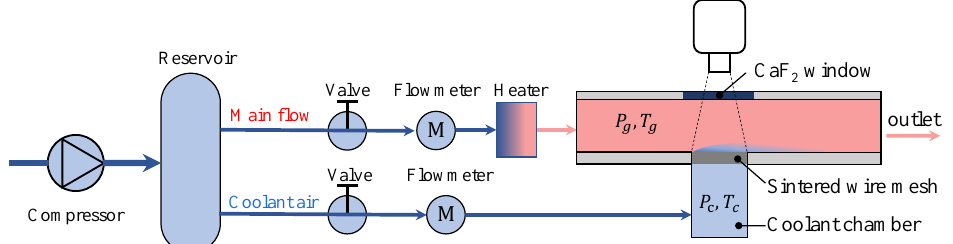
Figure 2. Schematic of the experiment apparatus for the measurement of the transpiration cooling characteristics of the sintered wire